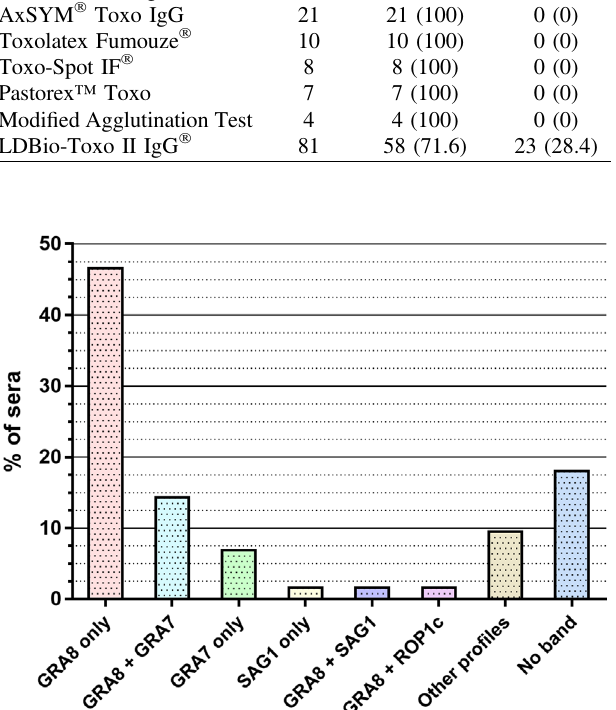
Figure 1. Description of the recom Line (cid:1) immunoblot pro fi les performed on the 189 suspected false-positive sera with Architect (cid:1) .